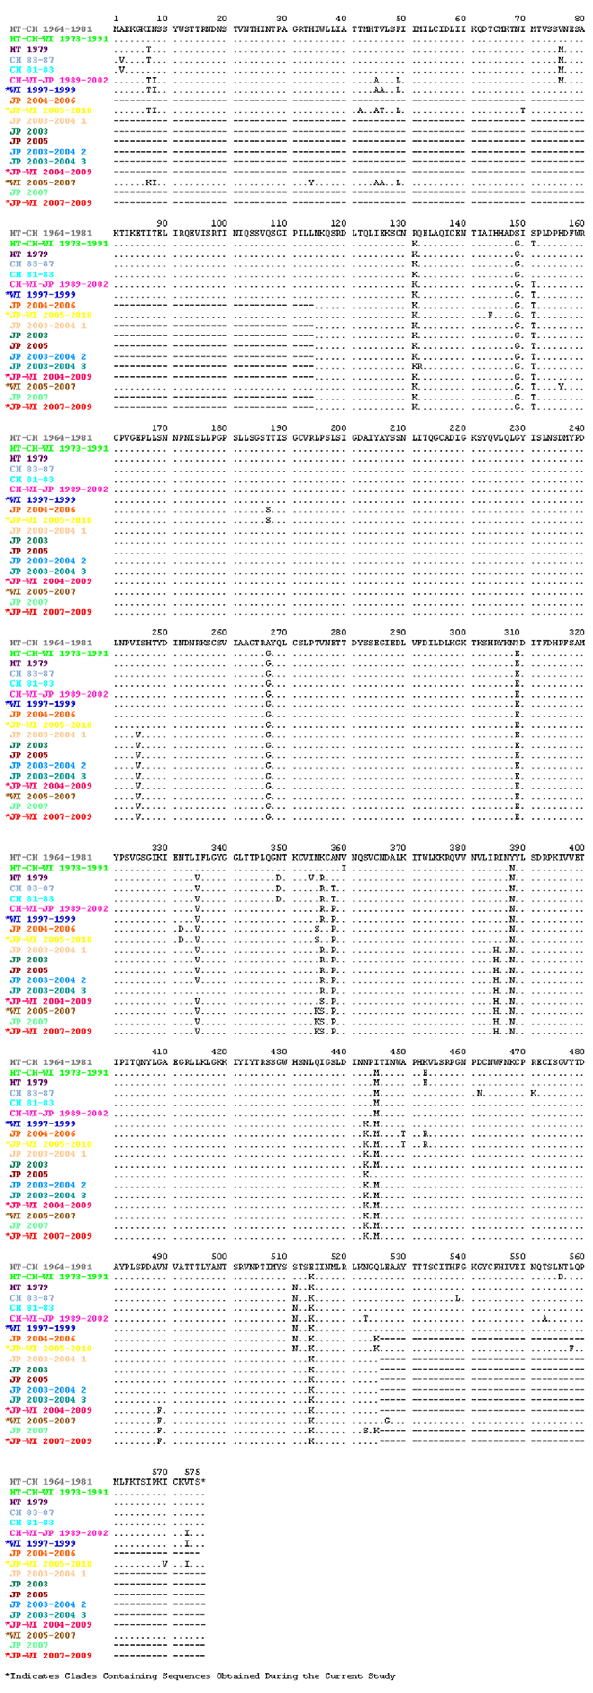
Figure 3. Amino acid sequence of the HN protein across all HPIV-1 clades. This figure shows the amino acid sequence of the HN protein across all HPIV-1 clades. Amino acid substitutions were determined with the MacClade program and the consensus HN gene sequence for each clade. The color of the branches in Figure 2 correspond to the color of the clade name in this figure indicating which viruses have each of the sequences listed